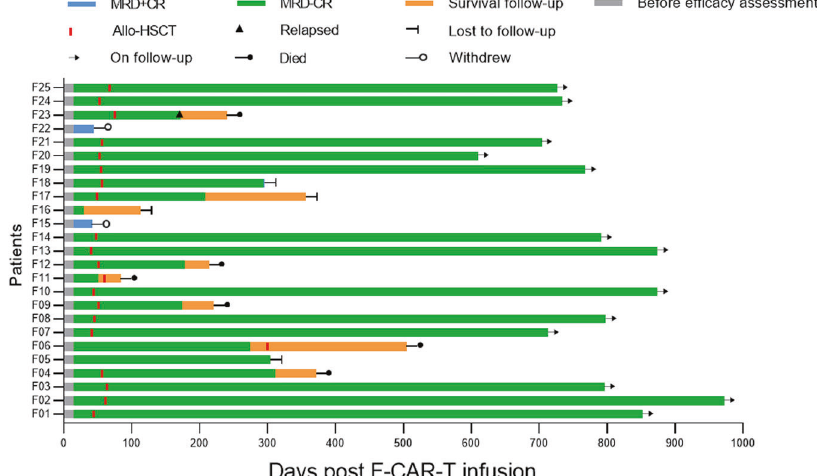
Fig. 4 Clinical outcomes of patients after F-CAR-T infusion. Clinical outcomes and consolidative allo-HSCT for the 25 patients who were treated with F-CAR-T therapy are shown. On day 28, 23/25 patients achieved MRD-negative CR/CRi. With a median time of 54 days (range: 45 – 81) post F-CAR-T infusion, 20 of 23 patients with MRD-negative status received consolidative allo-HSCT. Among the 20 patients, 1 patient (F23) relapsed on day 172 and died 3 months after relapse. Four patients (F04, F09, F11, F12) died from transplant-related mortality (TRM) including infection ( n = 3) and chronic GVHD ( n = 1) on day 84, day 215, day 220, and day 312, respectively. The remaining 15 patients were in MRD-negative CR except for one (F18) who became MRD-positive on day 294. Among the other 3 patients (F05, F06, F16), 1 remained MRD- negative CR on day 304, 1 remained in MRD-negative CR until day 303, received allo-HSCT, and subsequently died from an infection on day 505. One patient was lost to follow-up after day 114. MRD minimal residual disease, CR complete remission, Allo-HSCT allogeneic hematopoietic stem cell transplantation.